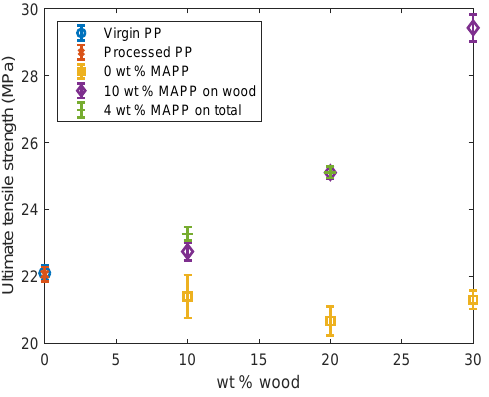
Figure 2. Ultimate tensile strength as a function of filler percentage for various compositions.